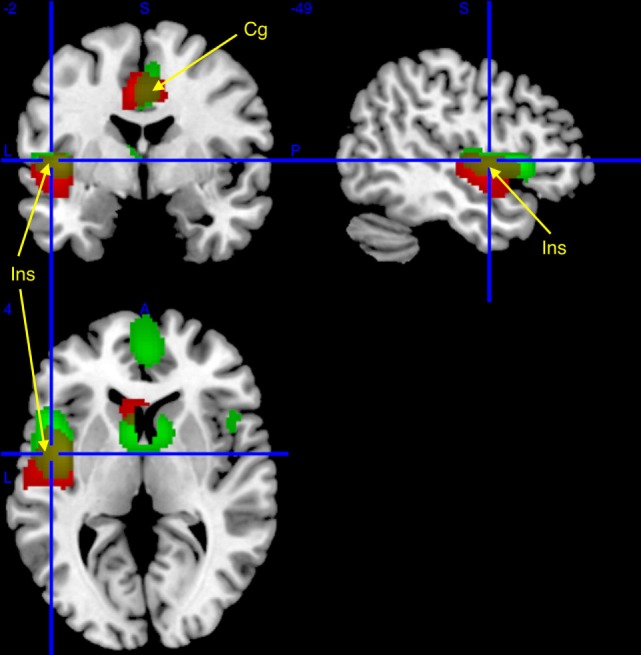
Regional cerebral increases in patients with narcolepsy type 1 (red) and idiopathic hypersomnia (IH) (green), as compared to healthy controls, superimposed on a template T1-weighted magnetic resonance image (MRI). Activations are displayed at punc < 0.001 uncorrected threshold, for clusters >50 voxels. Yellow clusters are area of similar hypermetabolism [insula (Ins) and middle cingulate (Cg); see arrows] in narcolepsy and IH as compared to controls.